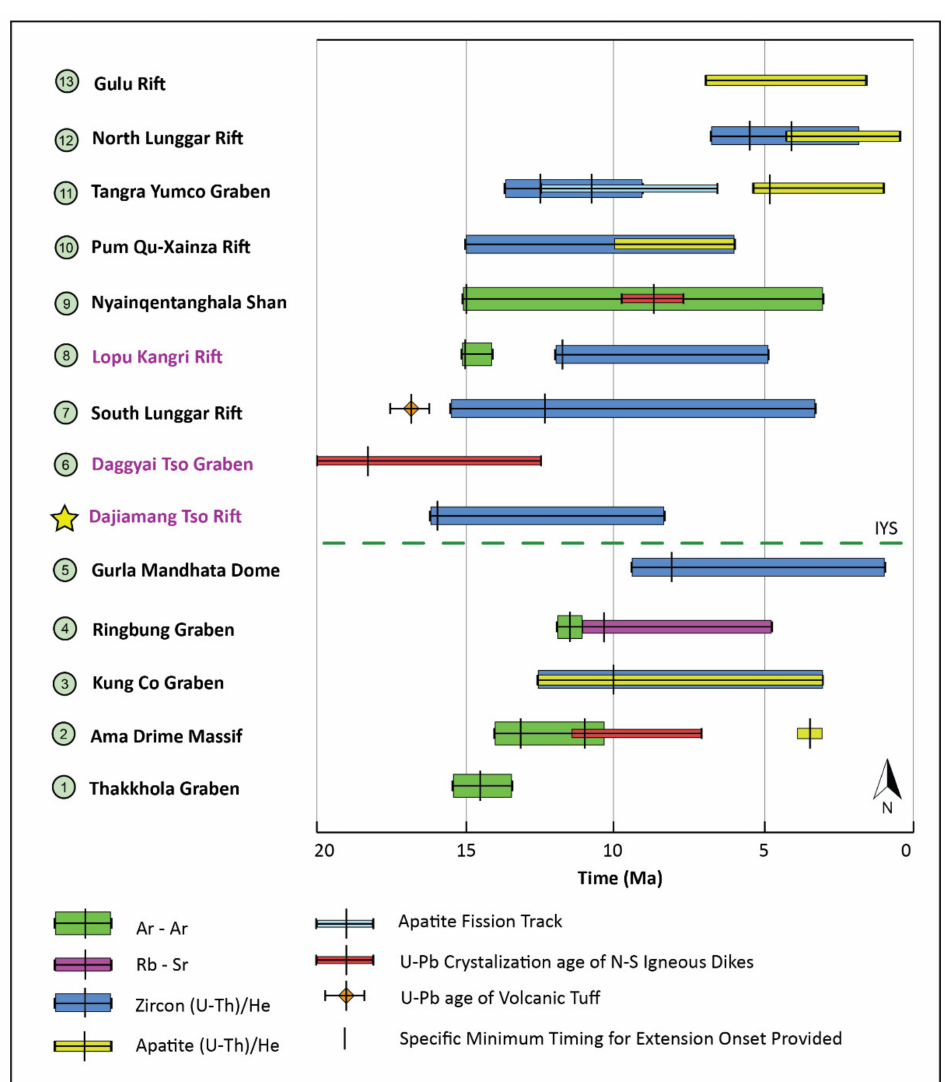
Figure 9. Regional correlation figure comparing ZHe cooling ages from this study to minimum timing estimates for the onset of east–west extension from previously studied rifts throughout central and southern Tibet. Rift numbers increase from SSW–NNE (measured orthogonal to the suture zone) and correspond to studies referenced in Figure 1. Gangdese rift names are labeled in purple (corresponding to Figure 1) and Tibetan rift names are labeled in black. The Indus-Yarlung suture zone is also included for spatial reference. Horizontal colored bars represent the range of measurements (including errors) while vertical black ticks represent the earliest evidence of extension observed for each technique. 1. Thakkhola graben [34], 2. Arma Drime massif [35], 3. Kung Co graben [36], 4. Ringbung graben [37], 5. Gurla Mandhata dome [38,39], 6. Daggyai Tso graben [40,41], 7. South Lunggar rift [24], 8. Lopu Kangri rift [42–44], 9. Nyainquentanghala Shan [45,46], 10. Pum Qu-Xanza rift [47], 11. Tangra Yumco graben [27,48], 12. North Lunggar rift [23,49], 13. Gulu rift